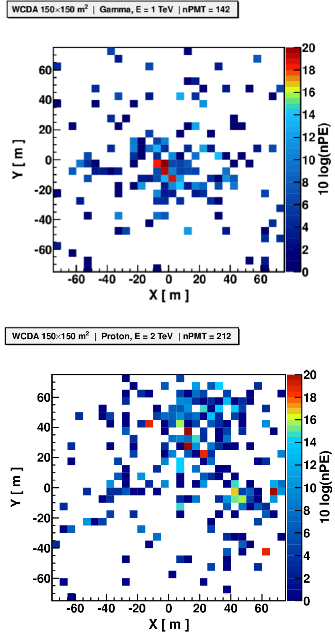
Figure 2. Two simulated events recorded by one of the pools of WCDA induced by 1 TeV gamma ray (upper) and 2 TeV proton (lower),